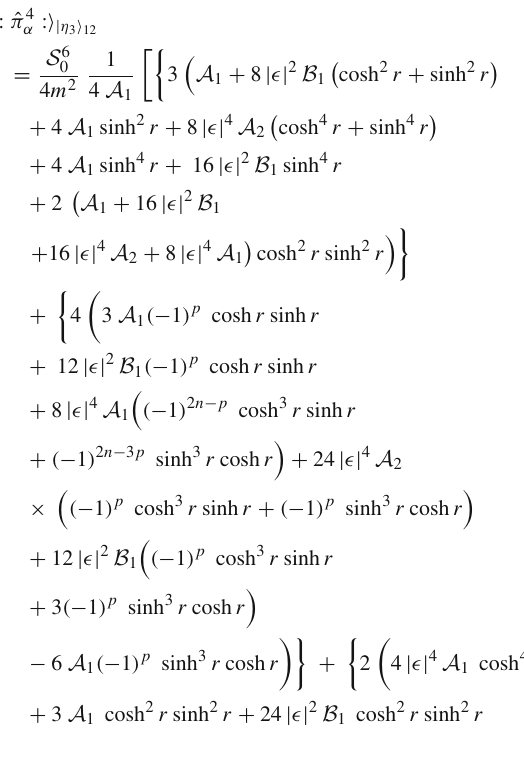
D T (cid:10) 1 only when | (cid:11) | (cid:14) r ,